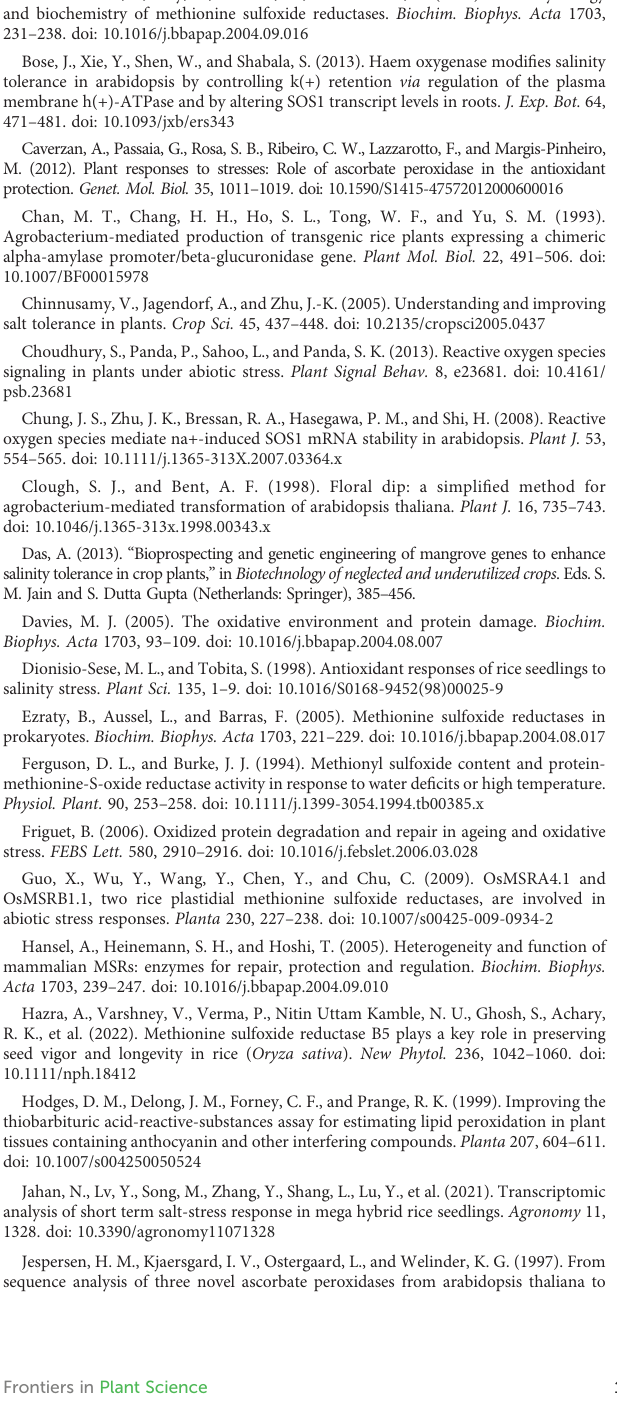
SUPPLEMENTARY FIGURE 5 Expression levels of OsMSRB genes under salt stress. Sixty-day-old rice seedlings were subjected to 250 mM NaCl treatment and samples (roots and shoots) were harvested at different time-points. RNA was extracted and the mRNA transcripts of OsMSRB genes in the aerial tissues (A) , and roots (B) , were quantitated by RT-PCR. Cycle numbers of RT-PCR are indicated at the rightsideof eachpanel.Os Act1 wasusedfornormalization. Data aremeans± SD of 3 independent